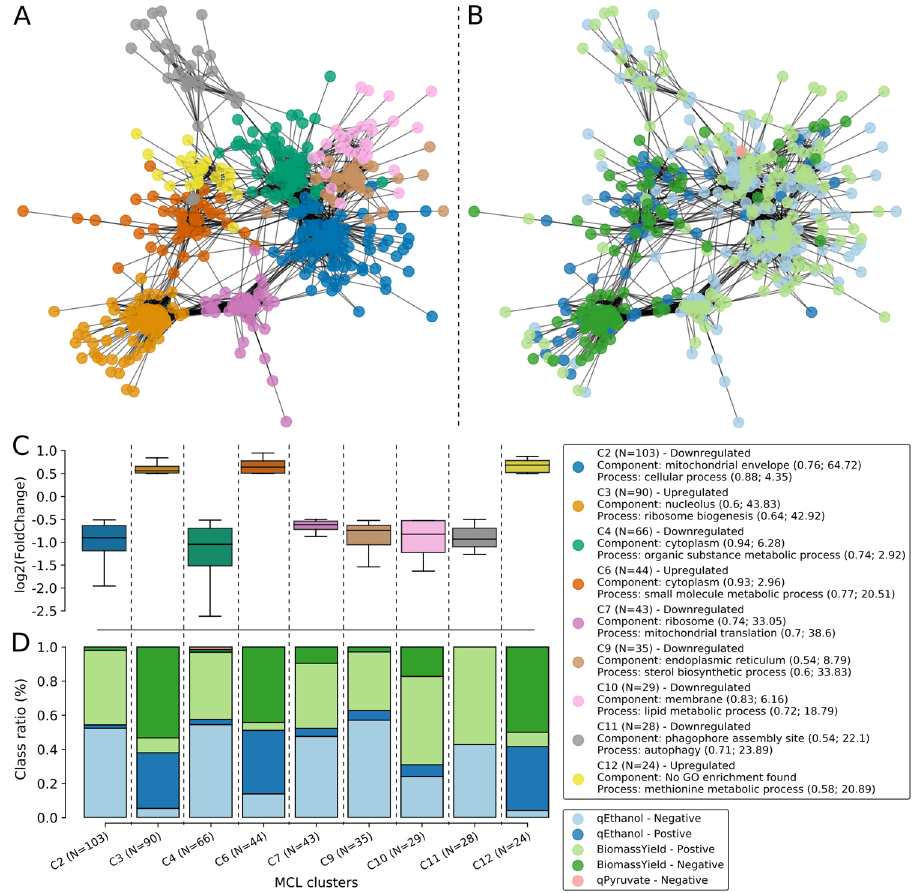
Figure 3. Co-expressed gene clusters can be classified according to functional enrichment and association with phenotype alterations. ( A , B ) Network representation of the 9 co-expressed gene clusters selected for further exploration. On the right ( A ), the clusters were classified according to their gene ontology functional enrichment; on the left ( B ) each gene in the network was classified according to their probability of having a positive or negative association with either qEthanol or biomass yield metabolic phenotypes. ( C ) Boxplot showing the expression profile (Y-axis) of each of the selected clusters (X-axis). The color of each cluster matches those of the network. ( D ) Stacked barplot showing the ratio of genes (Y-axis) associated with the metabolic classes (positive/negative relation to biomass yield/qEthanol) for each of the selected